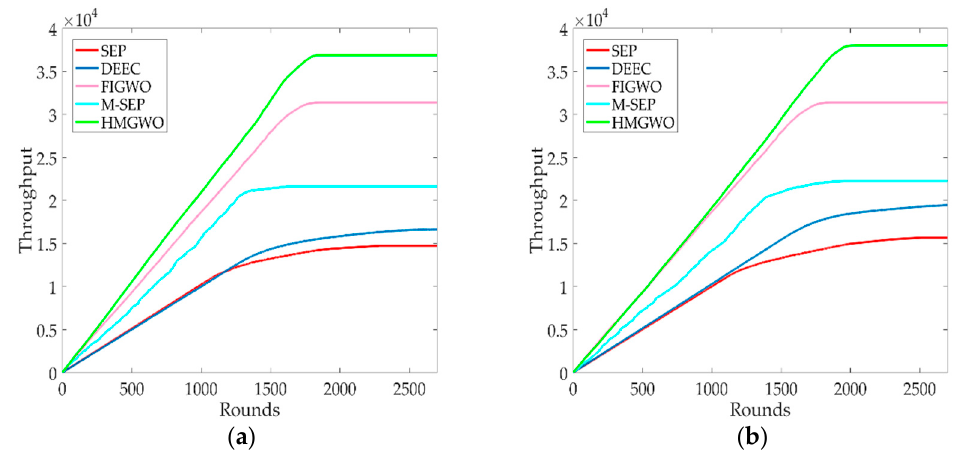
Figure 4. Number of data packets received by the base station. ( a ) The throughput of HMGWO against SEP, DEEC, M-SEP and FIGWO when 𝛼 is equal to 0.1; ( b ) The throughput of HMGWO is compared to SEP, DEEC, M-SEP and FIGWO when 𝛼 is equal to 0.2.